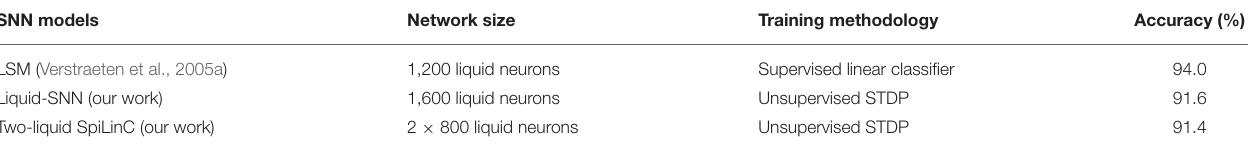
TABLE 6 | Classification accuracy of different SNN models (with similar audio pre-processing front-end) on 200 test samples from the TI46 speech corpus.